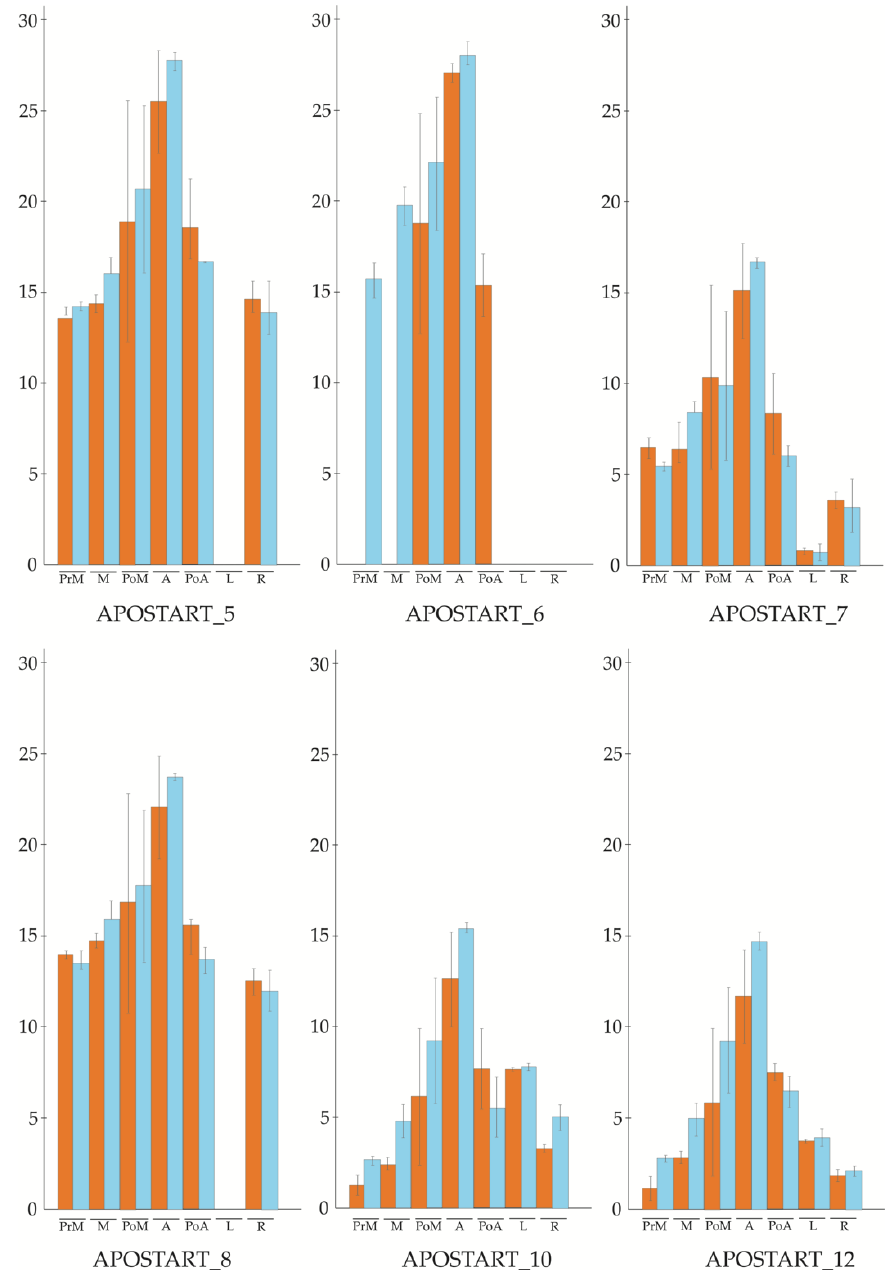
Figure 1. qPCR (quantitative PCR) profile of six APOSTARTs in two different sets of genotypes of P. pratensis (orange, apomictic genotypes; blue, sexual genotypes). The expression level was evaluated in five different flowering stages (pre-meiosis; meiosis; post-meiosis; anthesis; post-anthesis) and two tissues (leaves and roots).